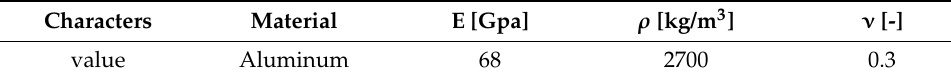
Table 8. Material properties for the wedge used for one-way coupling verification solution.